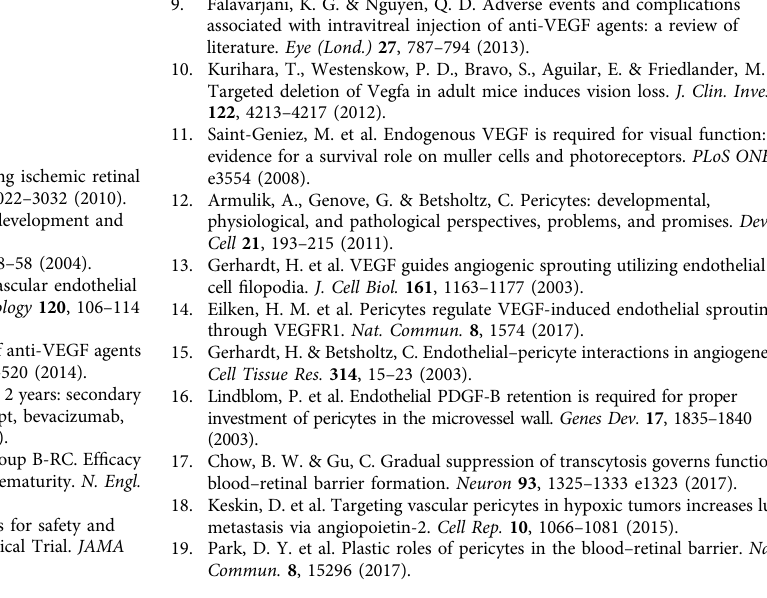
Fig. 9 Model for pericyte NCK1/2 function in vascular development and ischemic retinopathy. During angiogenic sprouting, tip cells express PDGF-B to recruit the pericytes and stabilize the new vessels. PDGFR β activation on the surface of pericytes leads to NCK1/2-dependent PAK activation and pericyte migration. Under ischemic conditions, high PDGF-B levels activate pericyte α -SMA expression and increase vessel coverage, including tip cells. Dysfunctional α -SMA + pericytes promote pathological angiogenesis and inhibit retinal revascularization. Inhibition of PDGF-B or PDGFR β downstream NCK1/2 signaling blocks pericyte recruitment and NVTs and promotes vessel regrowth in the OIR